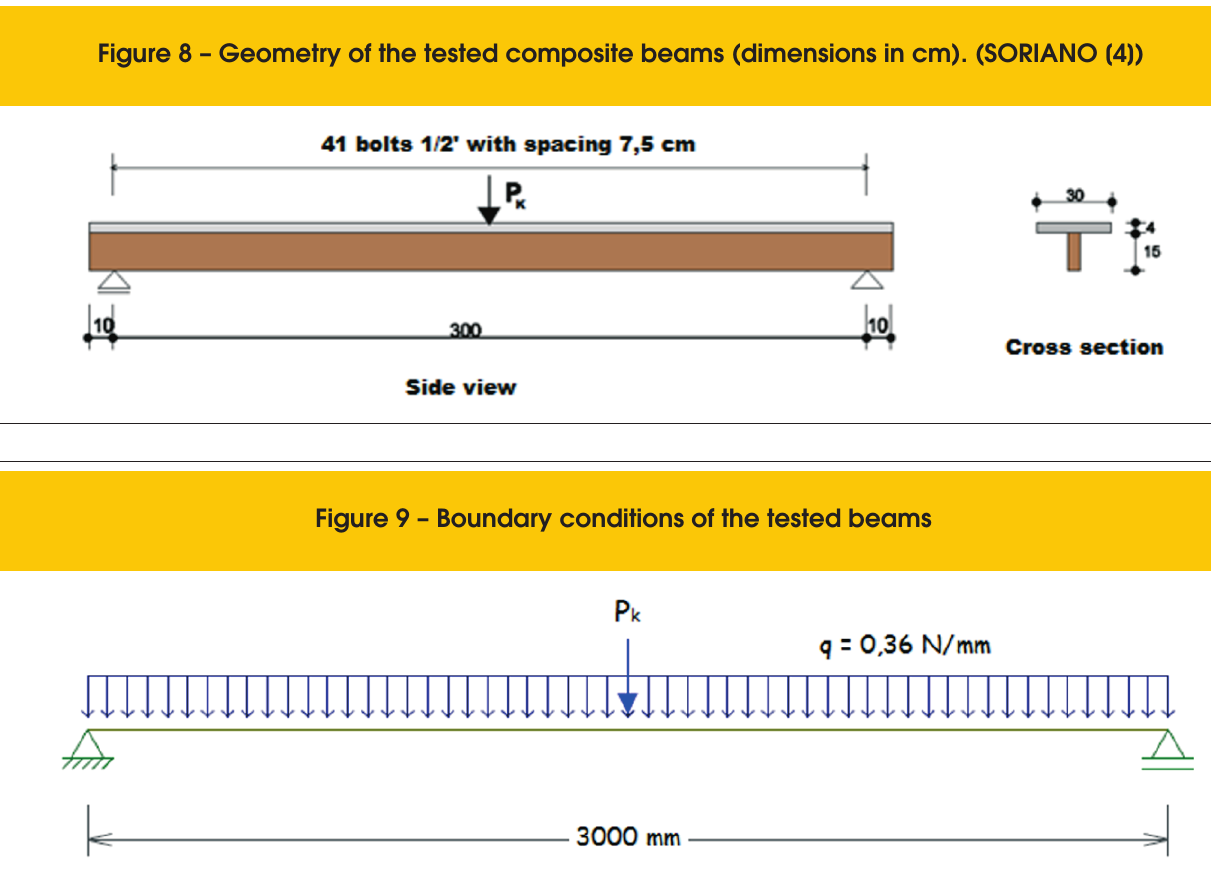
Table [2] brings the following results: 1. SORIANO [4]: the displacements from the two experimental tests (Exp. 1, Exp. 2, and the average values of the tests). It is worth noting that the structure collapsed in Exp. 1 and Exp. 2